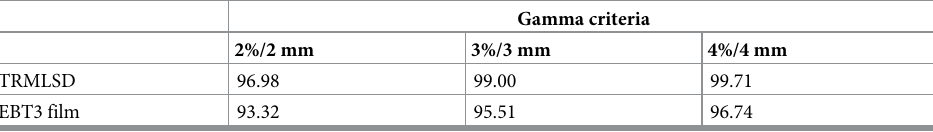
Table 5. Gamma passing rate of accumulated dose with the TRMLSD and EBT3 film compared with the